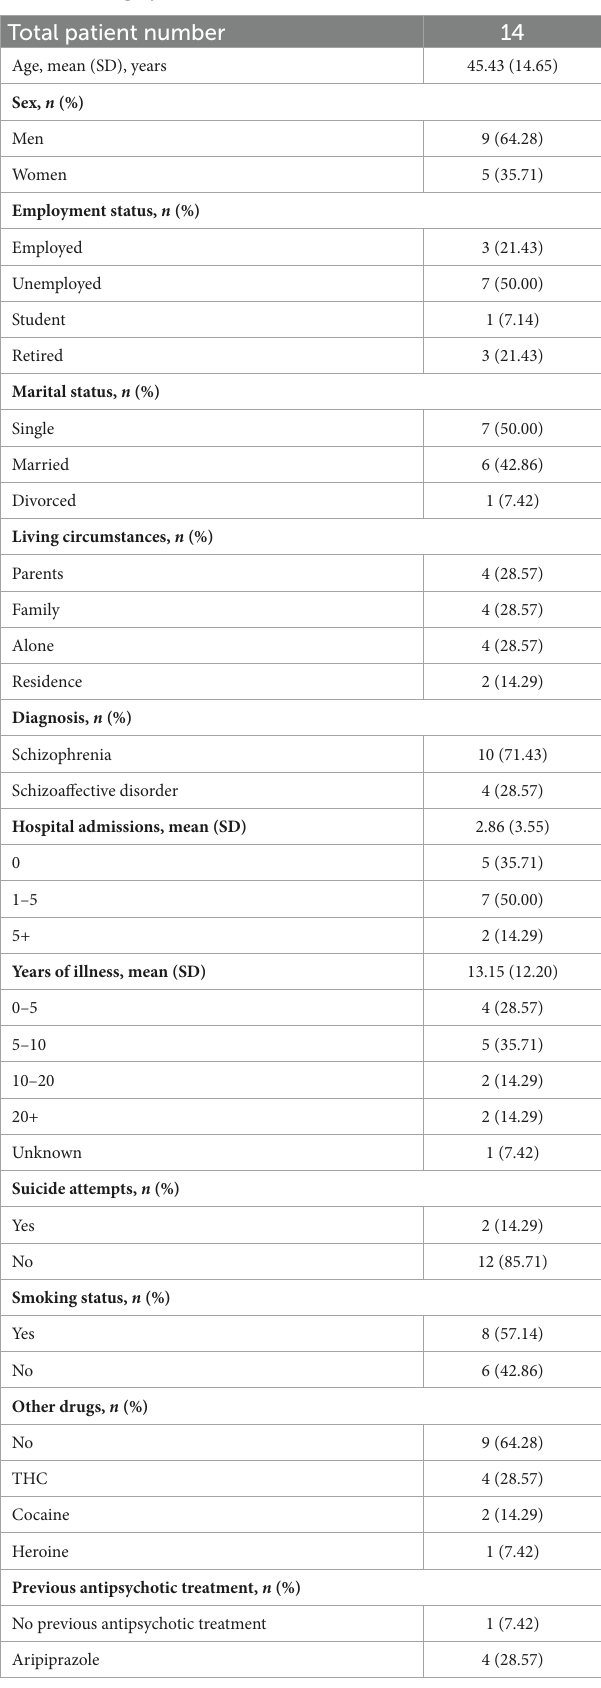
TABLE 1 Demographic, disorder, and treatment